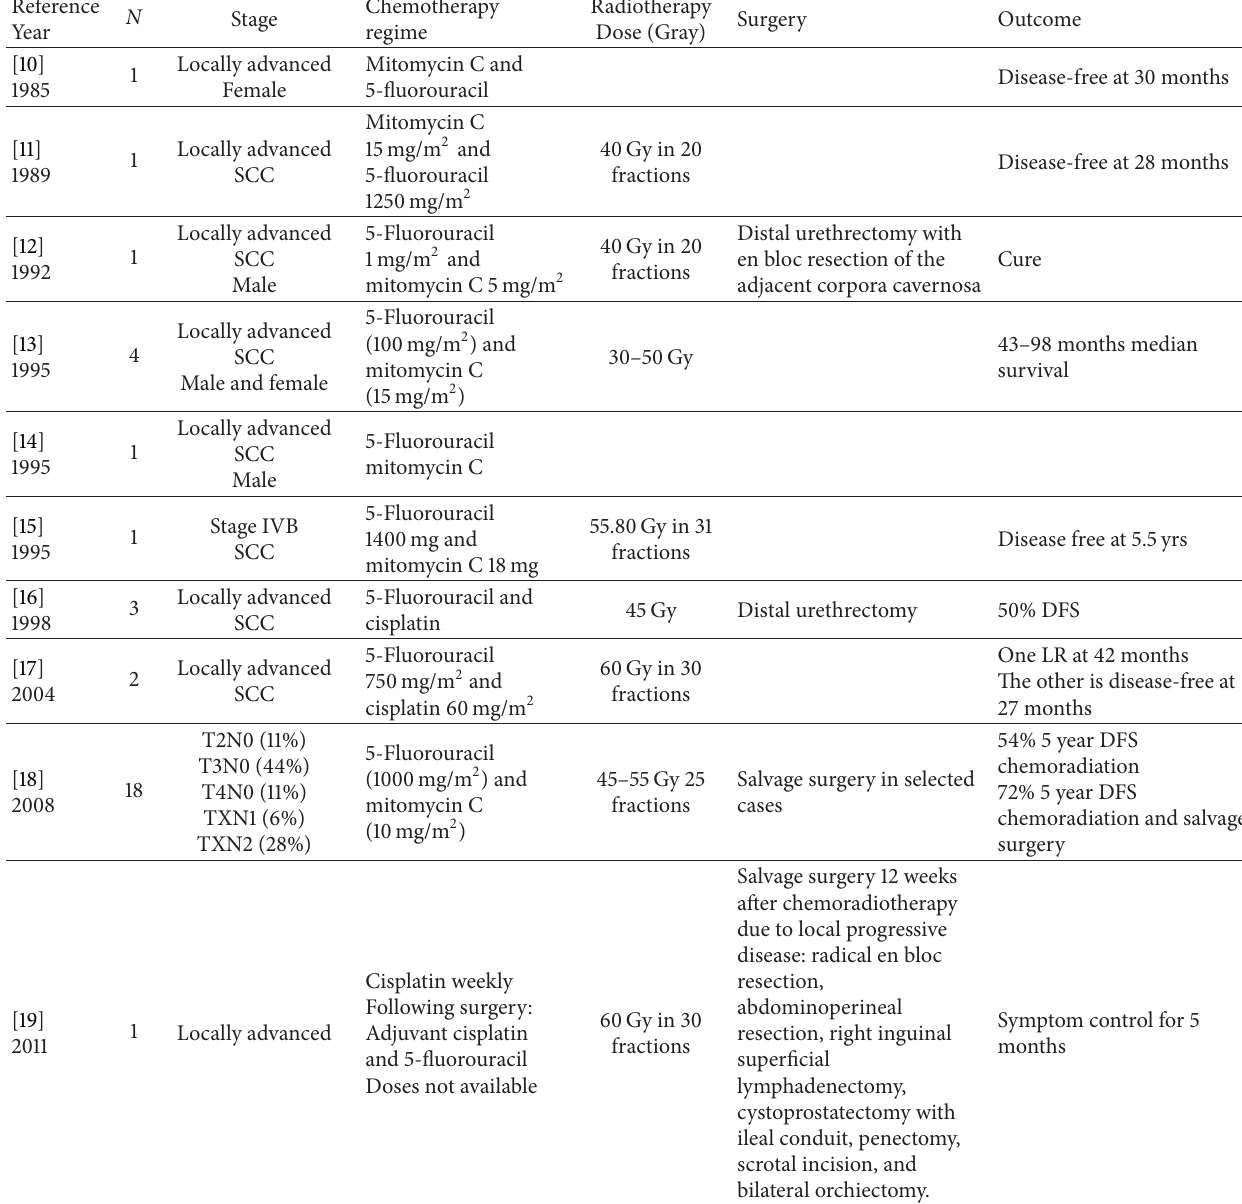
Table 1: Multimodality treatment of squamous cell carcinoma of the